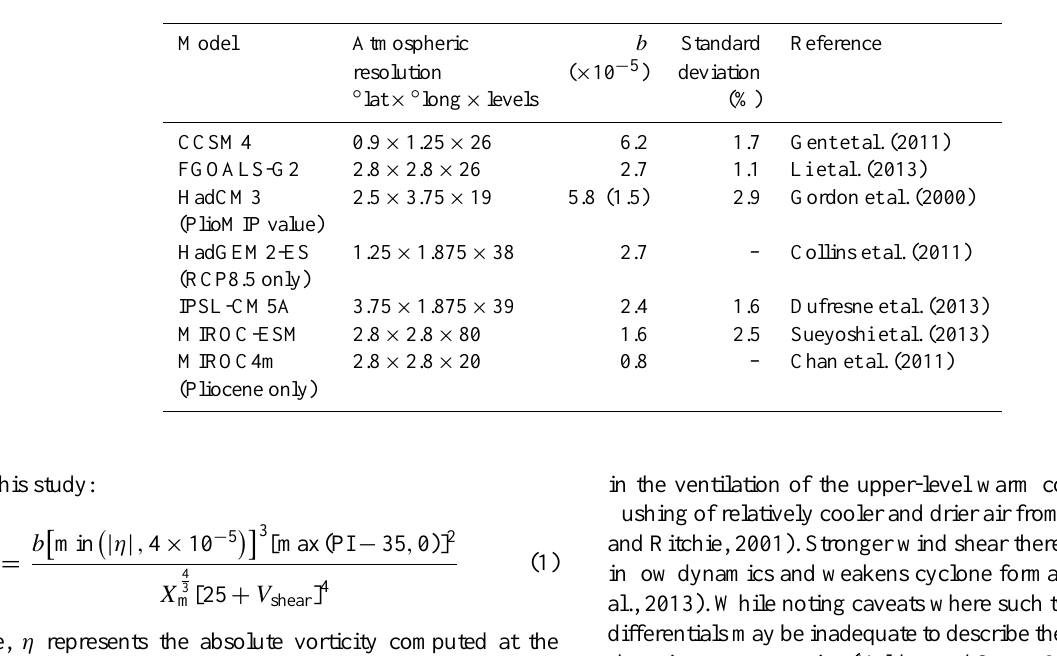
Table 2. List of GCMs used in this study. The b factor in the right column is incorporated into the GPI such that the global preindustrial value integrates to 90 annual occurrences for each GCM. HadGEM2-ES and MIROC4m are only used for the single time periods as indicated. The preindustrial simulation in PlioMIP for HadCM3 shows different behaviour to that of the PMIP simulations and so requires a different normalisation factor, b